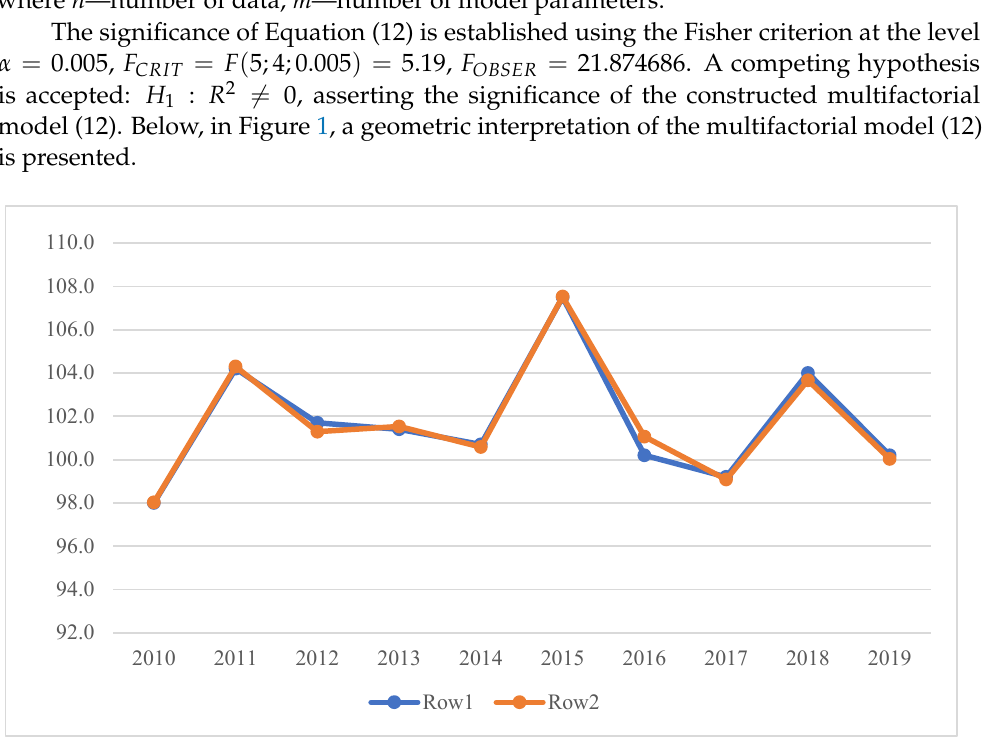
Figure 1. Geometric interpretation of multifactorial model (12) for the 2010–2019 data. Row 1 corresponds to the original data, row 2—to the constructed model.